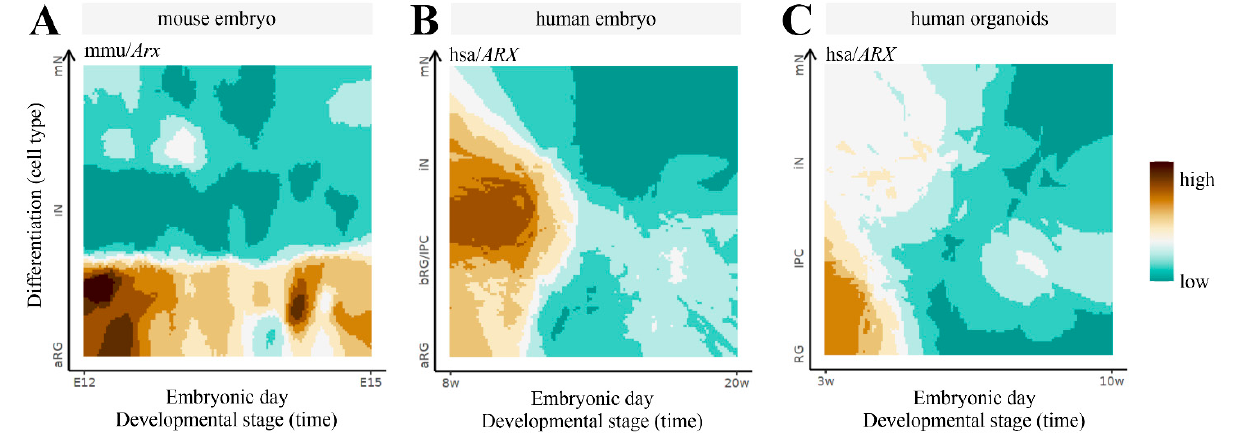
Figure 5. Spatiotemporal gene expression trajectories of Arx/ARX across the corticogenesis: in mouse, from the embryonic stage E12 to E15 ( A ); in humans, from gestation week 8 to 20 ( B ); and in human-derived brain organoids, from in vitro developmental week 3 to 10 ( C ). RG, radial glia; aRG, apical radial glia; vRG, ventral radial glia; oRG, outer radial glia; IPC, intermediate progenitor cell; BP, basal progenitor; N, neuron; iN, immature neuron; mN, mature neuron. Data can be accessed freely on http://www.humous.org/, accessed on 02/02/2022.